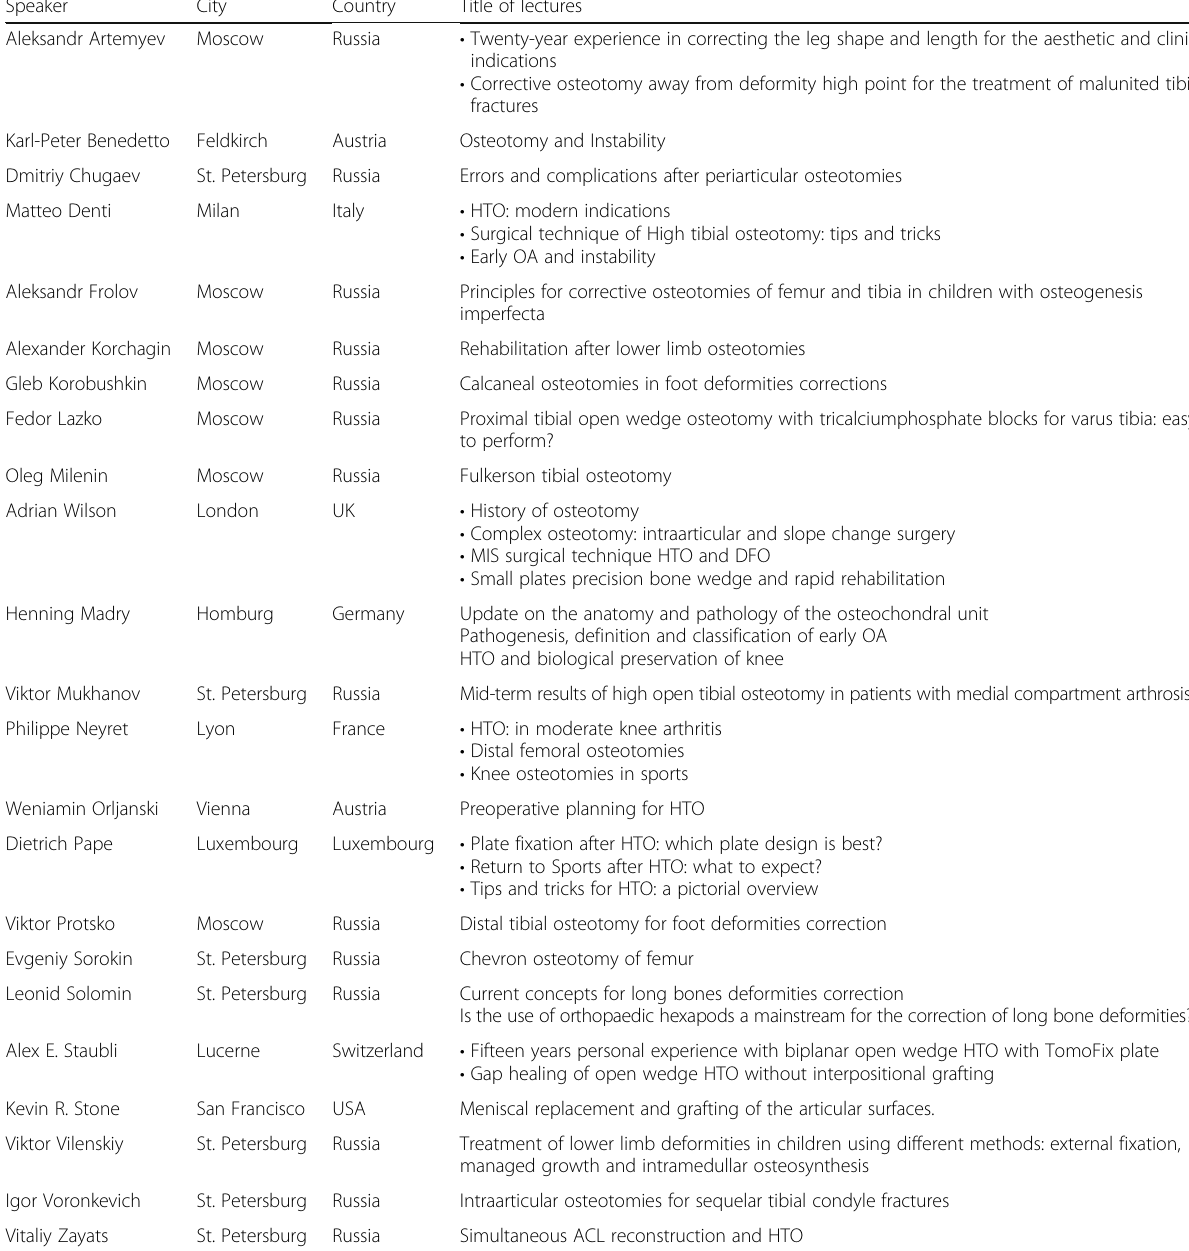
Table 1 Lectures of the ASTAOR Moscow International Osteotomy Congress